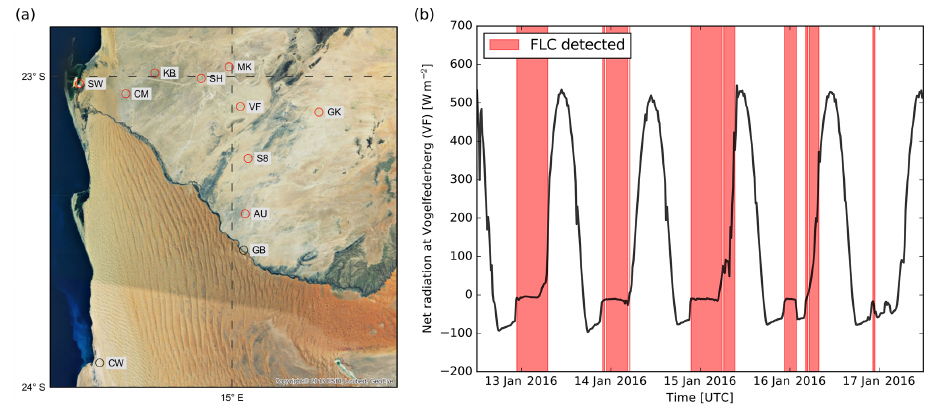
Figure 2. (a) Locations of the FogNet stations; definitions of abbreviations (station names) are listed in the appendix. Red markers indicate the stations used for validation in this study. (b) Exemplary time series of net radiation measurements at Vogelfederberg (VF). Highlighted in red are situations for which the satellite algorithm has detected